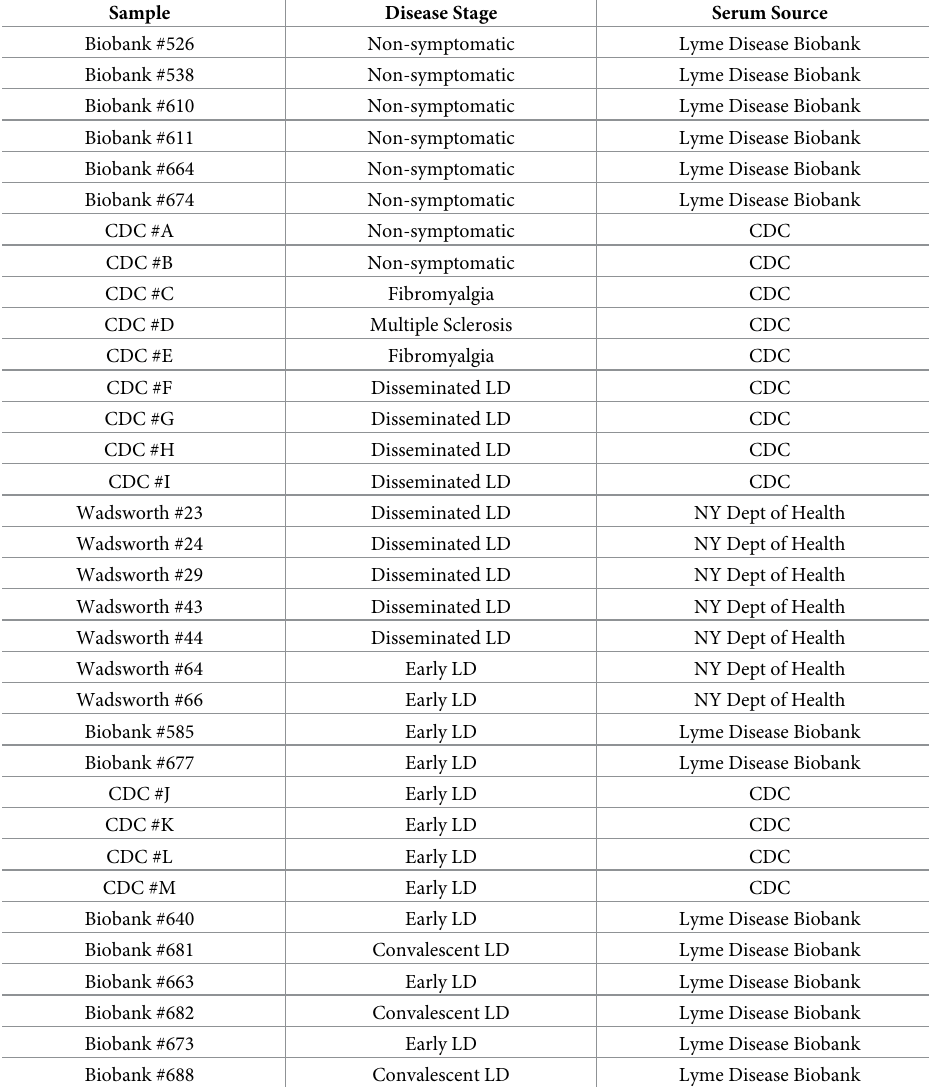
Table 2. Serum samples analyzed in this study. The blood serum of 34 individuals were analyzed, including LD patients and negative controls. LD-positive samples were reported to be either in the disseminated, early, or conva- lescent stages of disease depending on clinical history. Early and convalescent serum pairs from three patients are listed at the bottom of the table. All but the convalescent serum samples were used to train diagnostic algorithms for LD